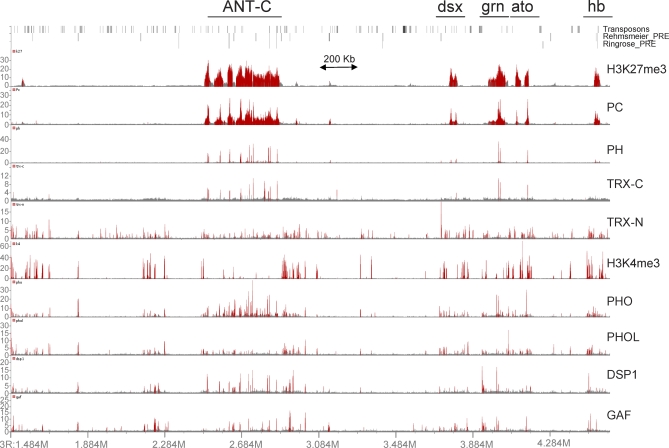
Genomic Distribution of PcG and TrxG Proteins and associated Histone Modifications in a Segment of Chromosome 3RThe plots show the ratios (fold change) of specific IP versus mock IP assays along part of the chromosome 3R. Significantly enriched fragments (p-value < 1E−04) are shown in red. All the profiles generated are available for viewing in an interactive browser at http://purl.oclc.org/NET/polycomb. Position of genes (FlyBase annotation 4.3) is shown at the top of the figure. Transposons and previously predicted PREs (M. Rehmsmeier, personal communication; [24,25]) are indicated by gray bars. Note that PC and H3K27me3 are bound to large genomic regions, whereas the other profiles show sharp localized binding. PcG recruitment factors were bound at PREs as well as at many other promoter regions where no PcG binding is detected. The N-terminal fragment of TRX (TRX-N) shows only weak binding to PREs, but colocalizes with H3K4me3 and sequence-specific DNA binding proteins at many promoter regions. The C-terminal fragment of TRX (TRX-C) is only strongly bound at PcG binding sites. ANT-C, Antennapedia complex; ato, atonal; dsx, doublesex; grn, grain; hb, hunchback.